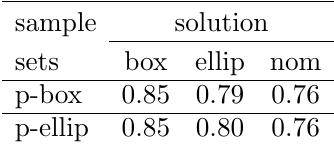
Table 5. Feasibility performance of